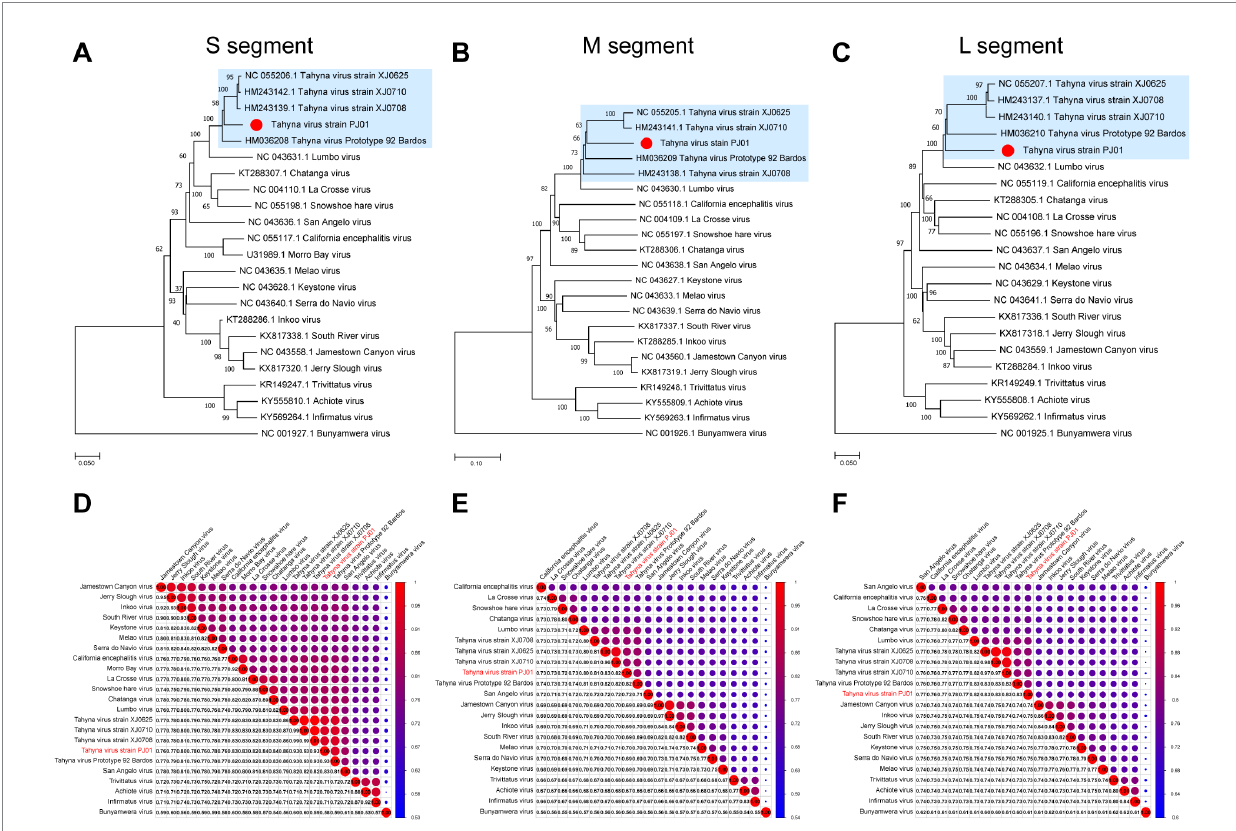
FIGURE 1 Neighbor-Joining phylogenetic trees (A–C) and pairwise distance (D–F) based on nucleotide sequences alignments of CSG of genus Orthobunyavirus . The Bunyamwera virus was used as an outgroup in the NJ trees. The scale bar indicates the evolutionary distance in the number of substitutions per nucleotide substitution/site, and the principal bootstrap support levels are